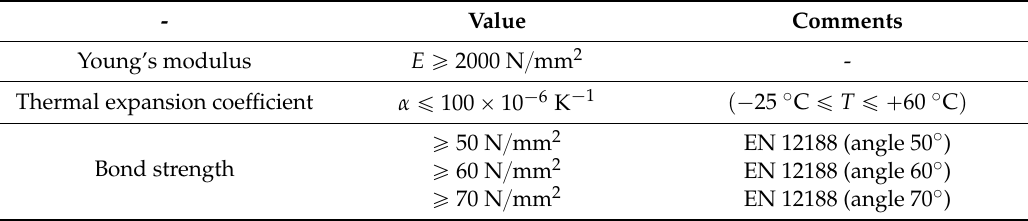
Table 2. Mechanical properties of Kerabuild Eco Epobond (from the manufacturer).